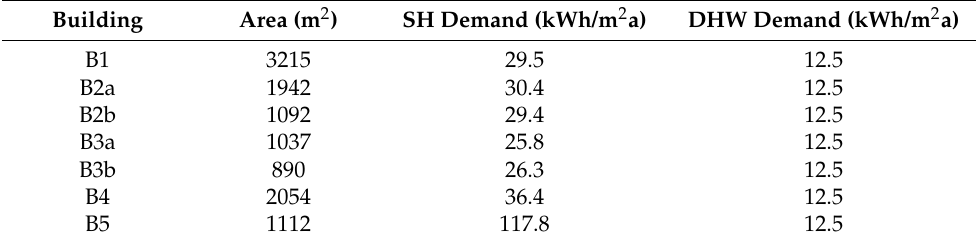
in Table 1. Table 1. Area, space heating and domestic hot water demand for each building in ENaQ.